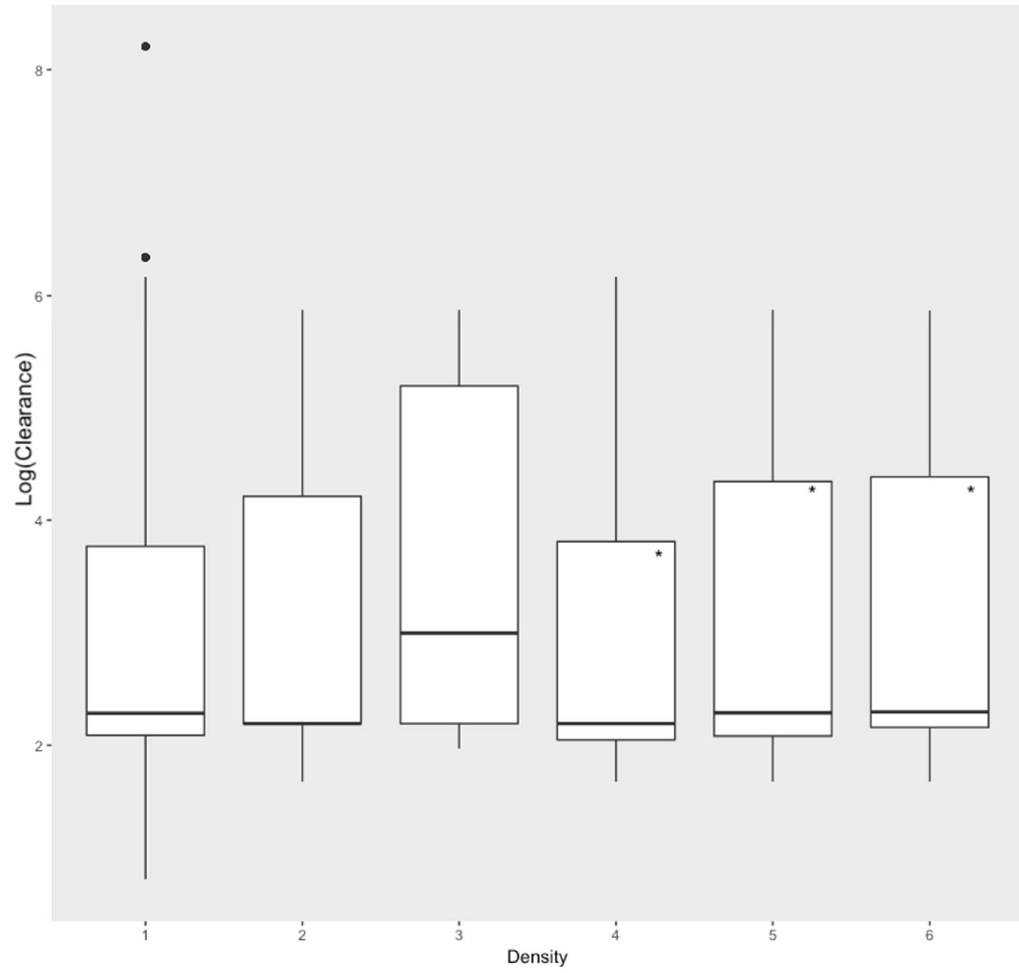
Figure 4. Predicted Log (Clearance) of sheep at different sheep densities (reference level is Density = 2). Density refers to sheep use of space. 1 = no sheep, 2 = free, 3 = loose, 4 = moderate, 5 = bunched, 6 = packed. Statistically significant results marked with an ‘*’. Table 4. Selected results of the linear mixed model examining factors affecting the rate of sheep movement per minute, showing only the statistically significant results. Reference level is Density =